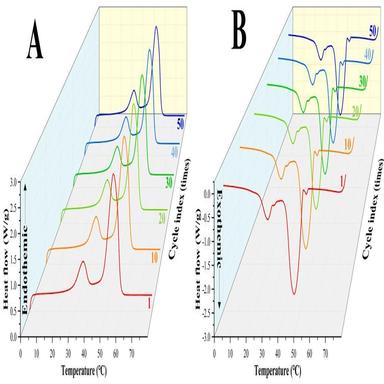
DSC curves of PS-5 under 50 loops of the heating-cooling cycle.